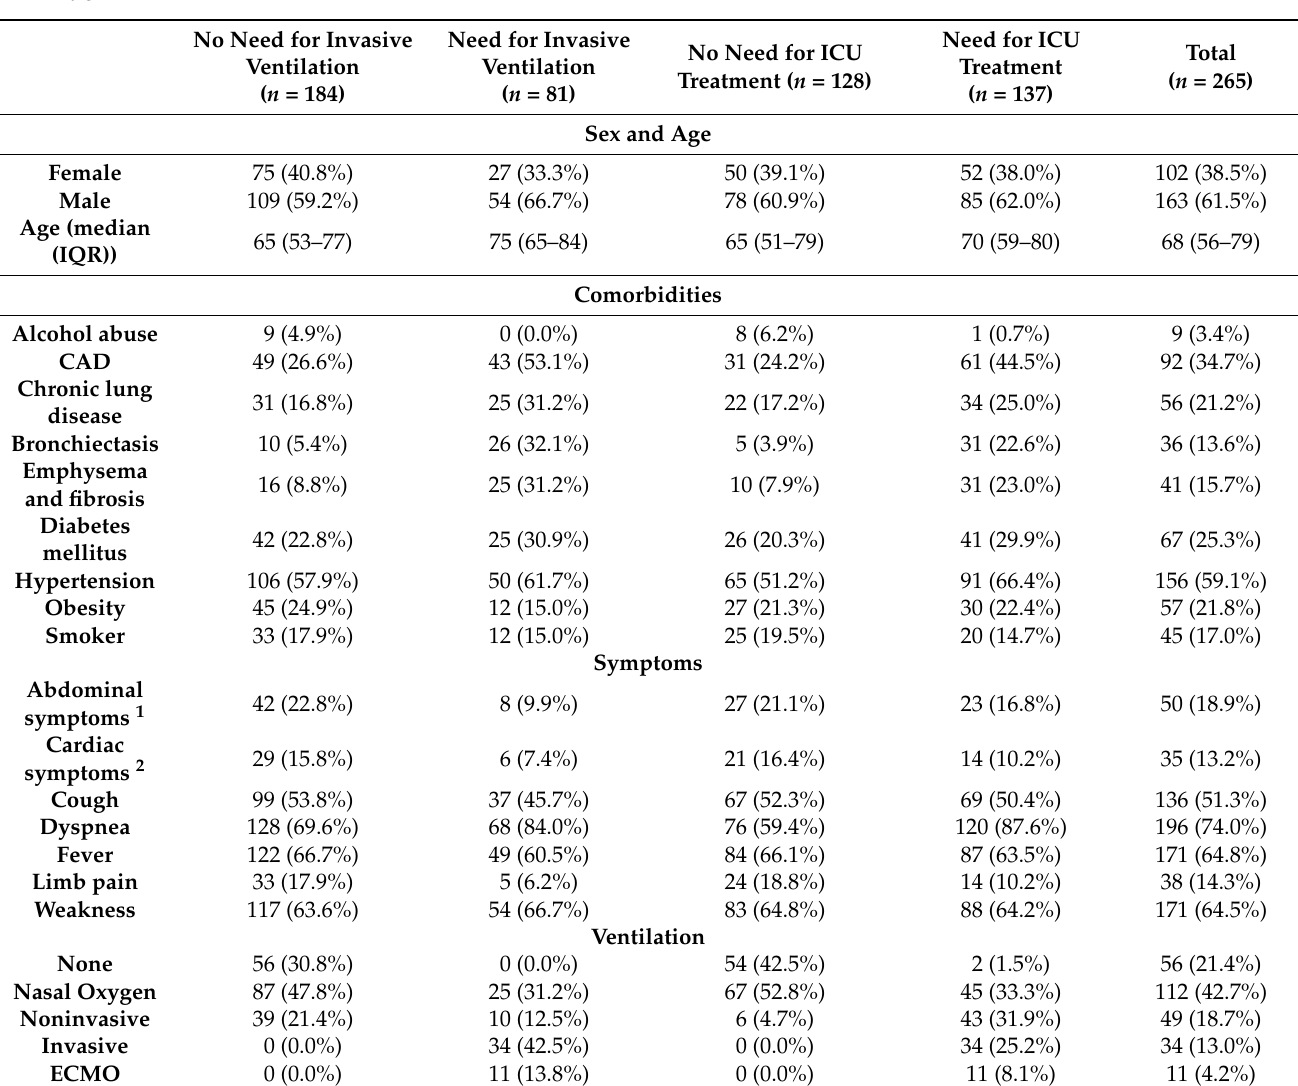
was used in 34 patients (13.0%), and 11 patients even required ECMO treatment (4.2%). A total of 137 patients had an indication for ICU treatment (51.5%), while 114 patients were actually admitted to the ICU (42.9%). Eighty-one patients had an indication for invasive ventilation (30.5%), but only 45 were intubated (16.9%). The study patients had a median age of 68.0 years, and patients requiring ICU treat- ment (median 75.0 years) and invasive ventilation (median 70.0 years) were slightly older. The majority of patients were male ( n = 163, 61.5%). Patients with a need for ICU treatment or invasive ventilation more often had comorbidities such as diabetes mellitus, hyperten- sion, or chronic lung disease (Table 1). Table 1. Summary of demographic and other patient data by endpoint and in the total study population. Median patient age was 68.0 years, patients with need for ICU treatment (median 75.0 years) and need for invasive ventilation (median 70.0 years) were slightly older. Most patients were male ( n = 163, 61.5%). Patients with need for ICU treatment or need for invasive ventilation more often had diabetes mellitus, hypertension, or a chronic lung disease. The most frequent symptoms were weakness (64.5%), fever (64.8%), and cough (51.3%). The majority of patients required nasal oxygen in the course of the disease (42.7%). Abbreviations: IQR: interquartile range, CAD: coronary artery disease, ECMO: extracorporeal membrane